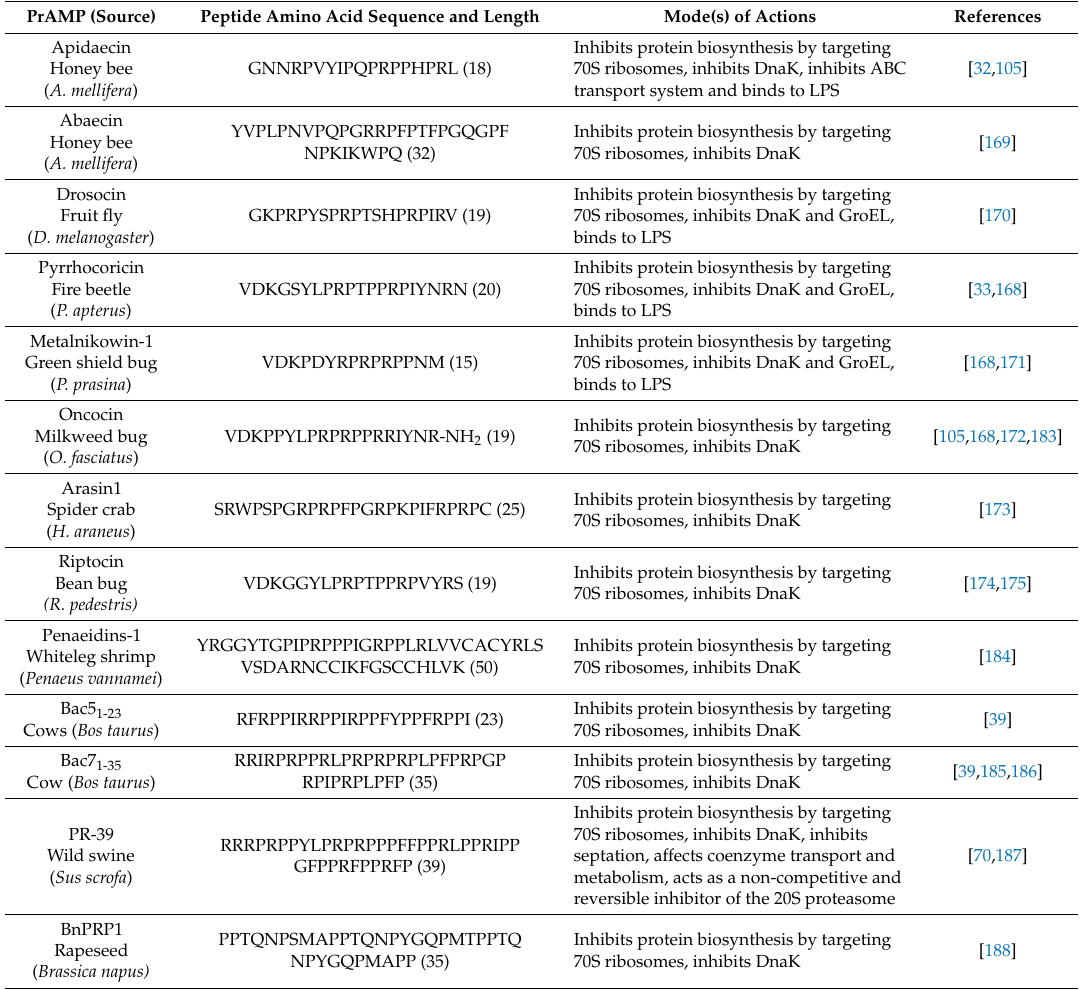
Table 3. Proline-rich AMP, their sequences and mode of